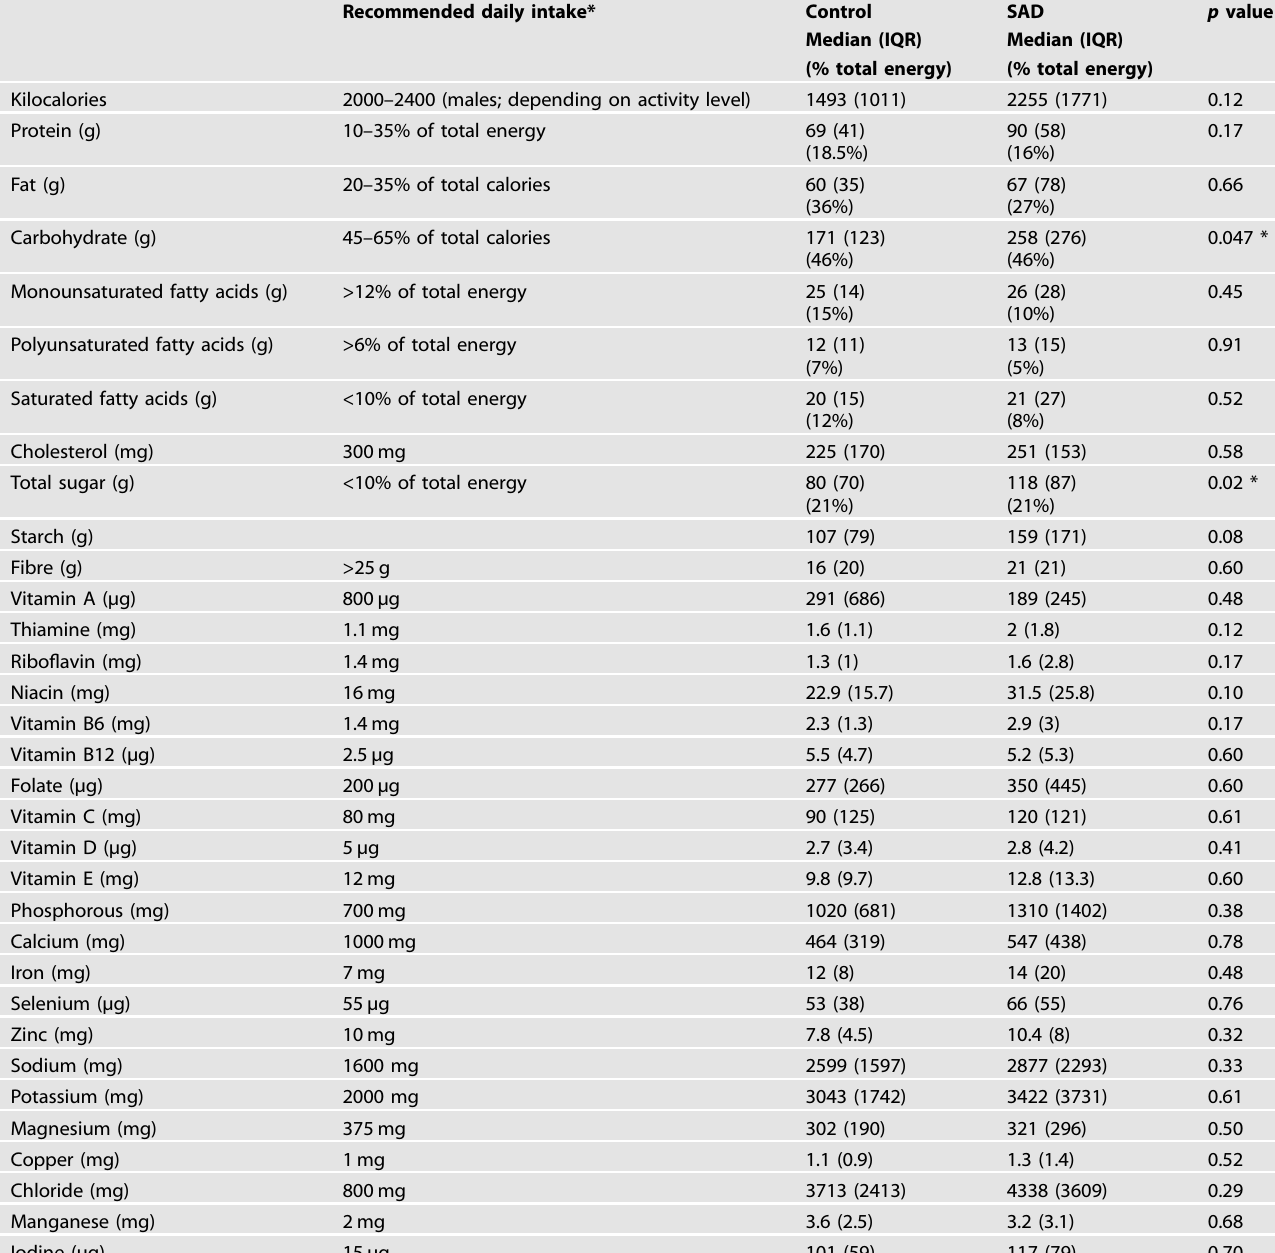
Table 2. Dietary intake (median (IQR)) obtained from analysis of food frequency